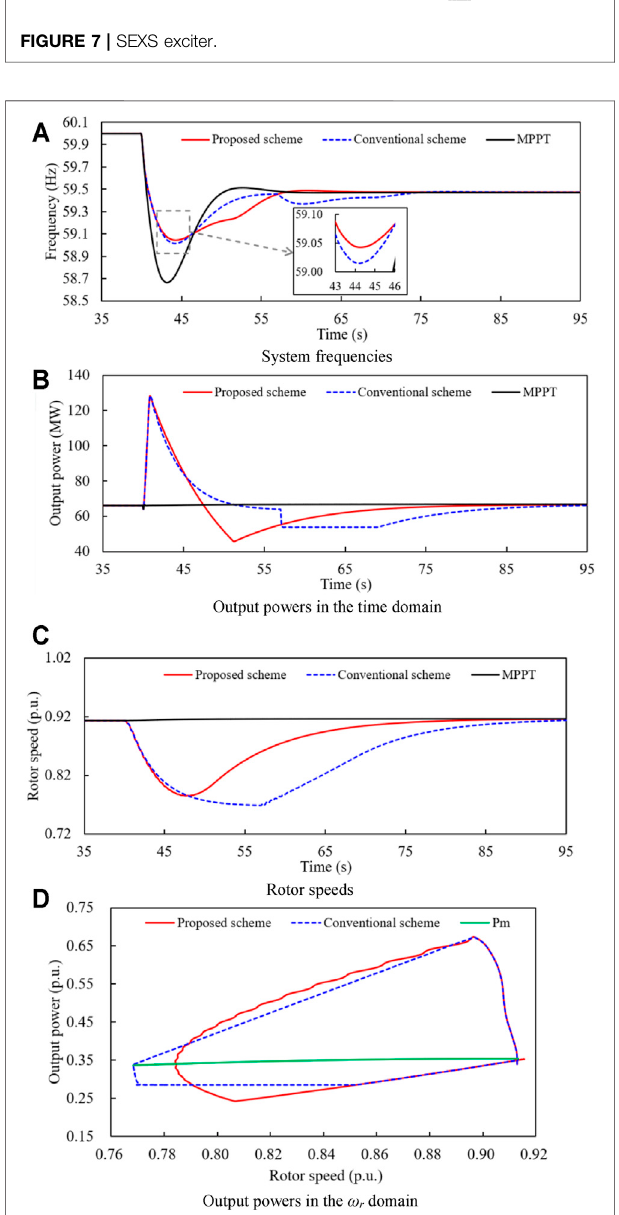
FIGURE 8 | Simulation results for case 1. (A) System frequencies. (B) Output powers in the time domain. (C) Rotor speeds. (D) Output powers in the ω r domain. setting of α is critically important. Besides, P ref should be limited by an active power rate limiter and a maximum power limiter.